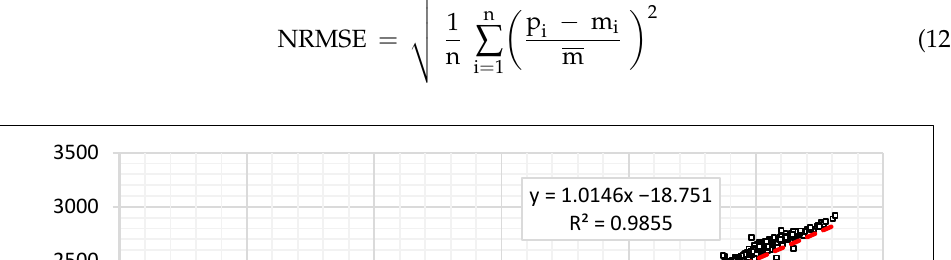
Table 2. Control limits for Shewhart chart.